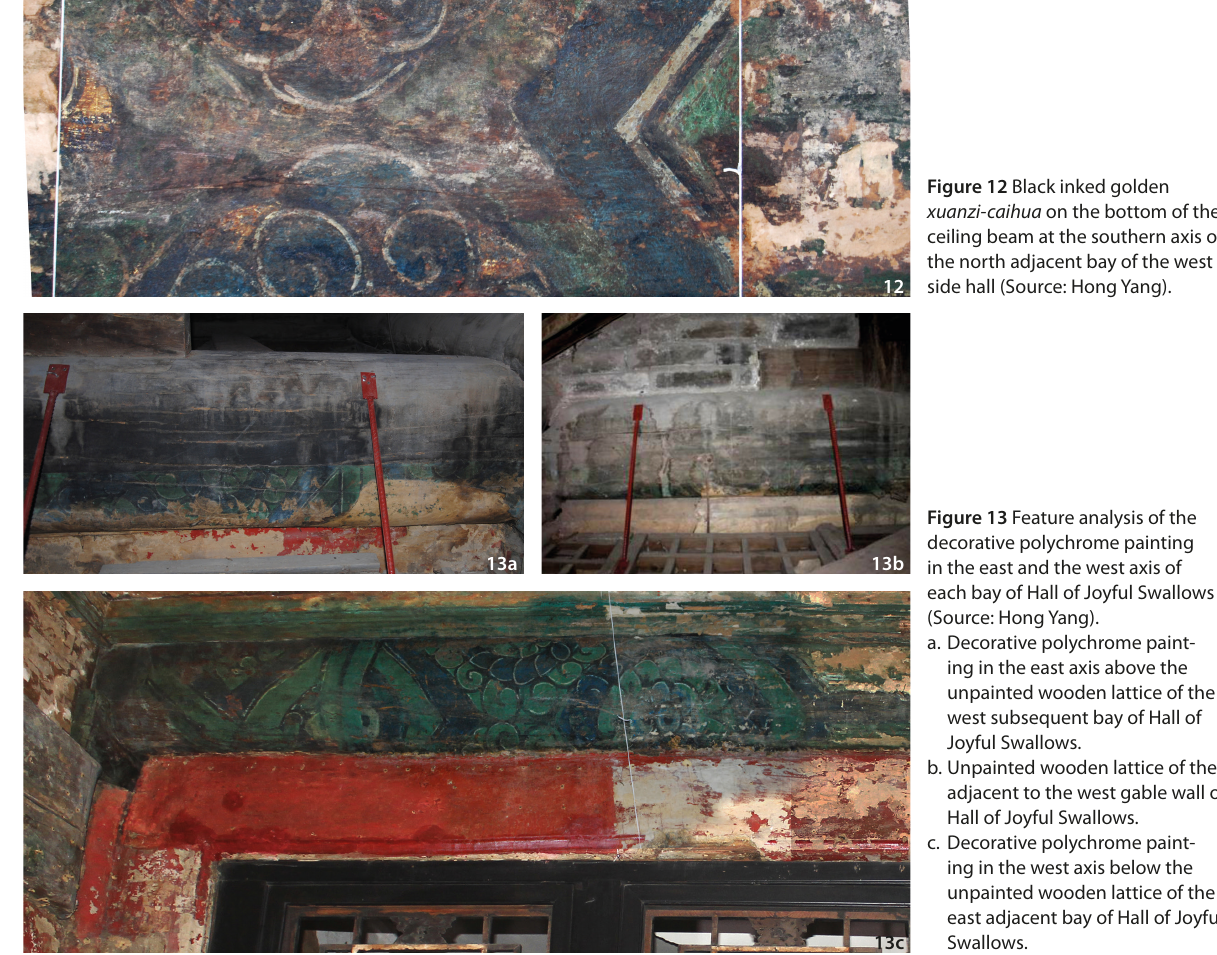
Figure 12 Black inked golden xuanzi-caihua on the bottom of the ceiling beam at the southern axis of the north adjacent bay of the west side hall (Source: Hong Yang).